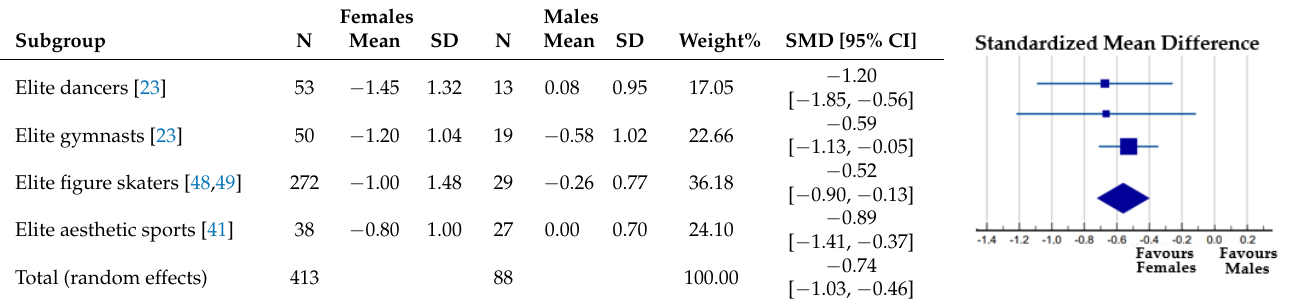
Table 6. Effect of gender on Sport-BID in elite aesthetic athletes.